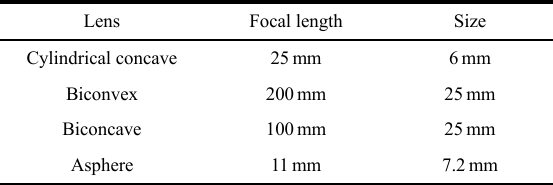
Table 2 List of test specimens used for the experiment